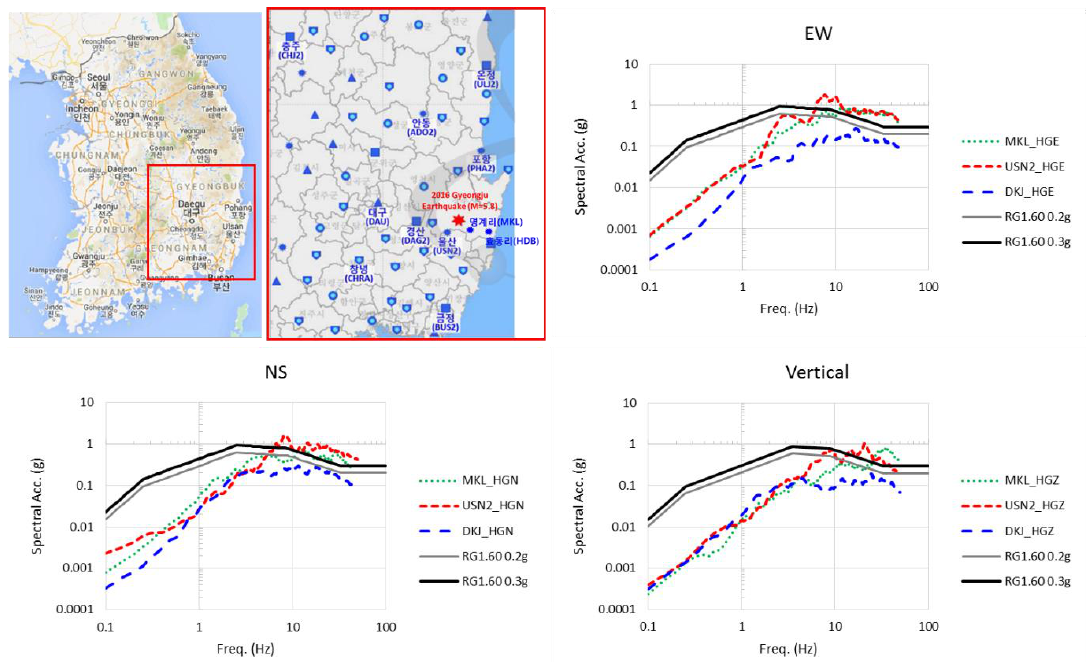
Figure 1. Comparison between the response spectra obtained from ground motions at the observation posts of USN2 (Ulsan), DKJ (Deokjeongli), and MKL (Myeongkaeli) measured in the 2016 Gyeongju earthquake and the design response spectrum of USNRC RG 1.60.